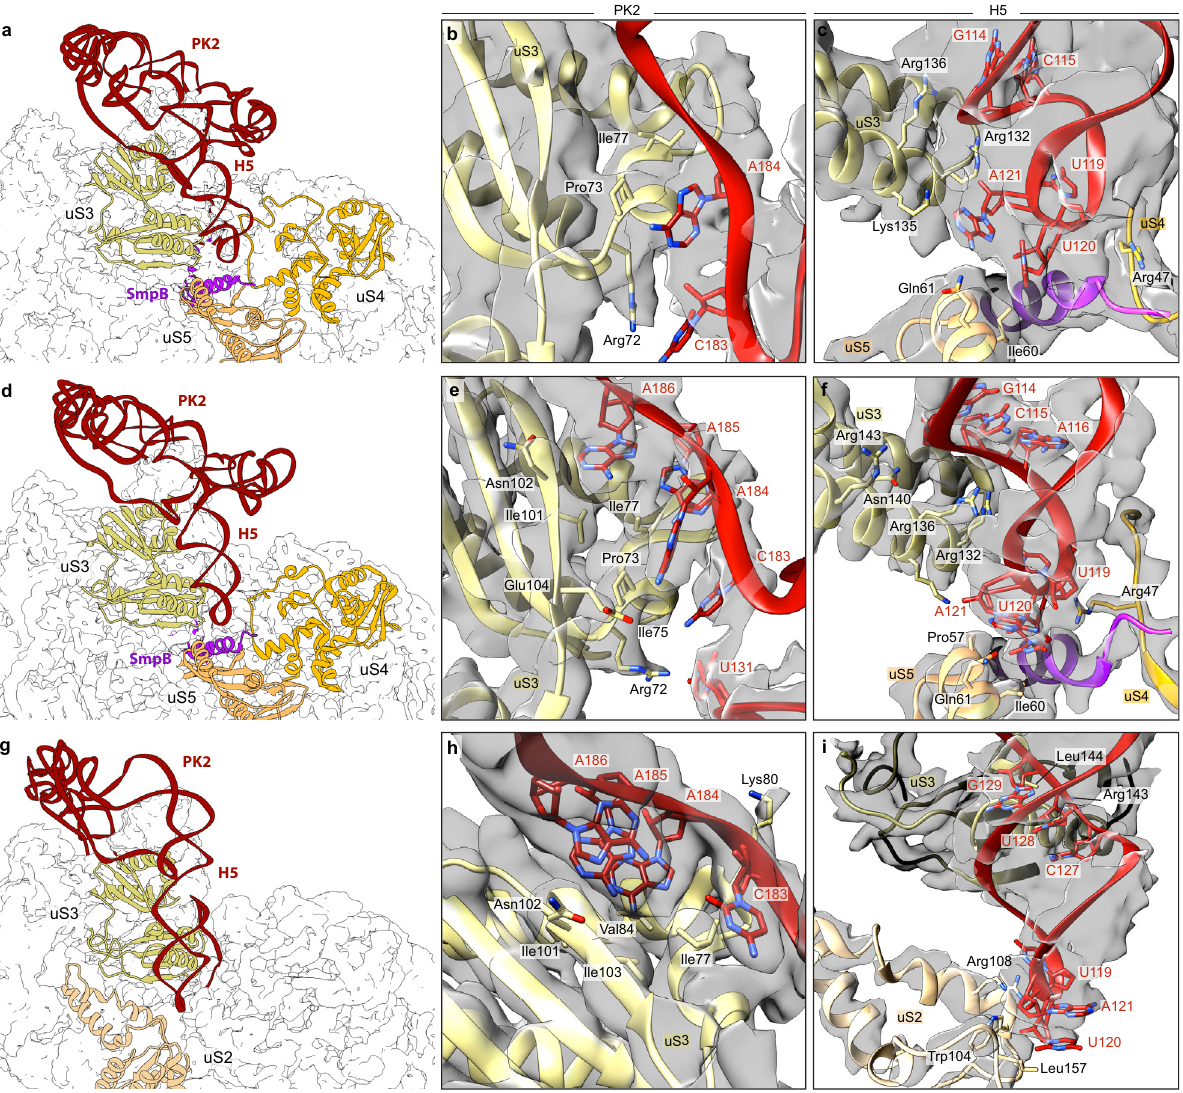
Fig. 2 The H5 and PK2 domains of tmRNA interact with the uS2, uS3, uS4 and uS5 proteins on the small ribosomal subunit. Shown are the a – c pre- accommodation state, d – f accommodation state, and g – i translocation state. Left column, overview of the interactions between tmRNA (red), SmpB (purple), and the ribosomal proteins uS2 (tan), uS3 (khaki) uS4 (gold) and uS5 (sandy brown). To highlight the motion of the H5 stem-loop during translocation, all structures are aligned on uS3. Middle, close-up of the interactions between the PK2 pseudoknot and uS3 ’ s KH2 RNA-binding domain. Right, close-up of the interactions between the H5 stem-loop and SmpB, uS3, uS4 and uS5. Residues and nucleotides within 4 Å of each other are indicated, and the cryo-electron density map is